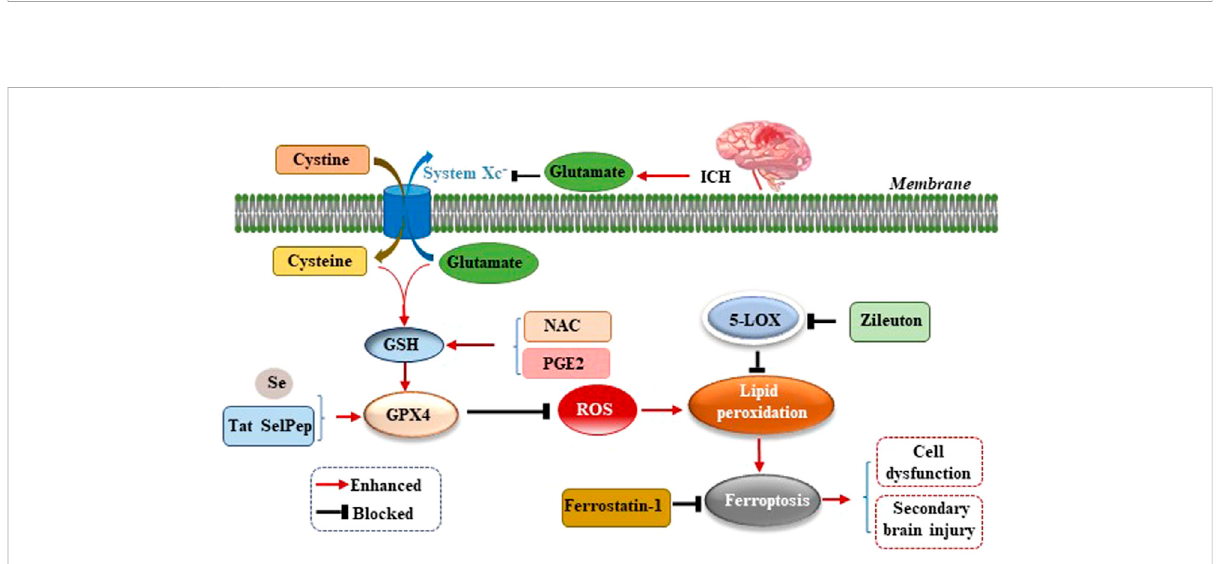
FIGURE 2 Mechanism of ferroptosis following ICH by inhibiting cystine/glutamate antiporter (System Xc − ). After ICH occurs, excessive glutamate (Glu) around neurons inhibits the activity of System Xc − and the transfer of cysteine (Cys), leading to reduction of glutathione (GSH) synthesis, which reduces the activity of glutathione peroxidase 4 (GPX4), resulting in excessive reactive oxygen species (ROS) and lipid peroxide levels which cannot be scavenged, thereby leading to neuronal ferroptosis, cell dysfunction, and secondary brain injury (SBI) caused by